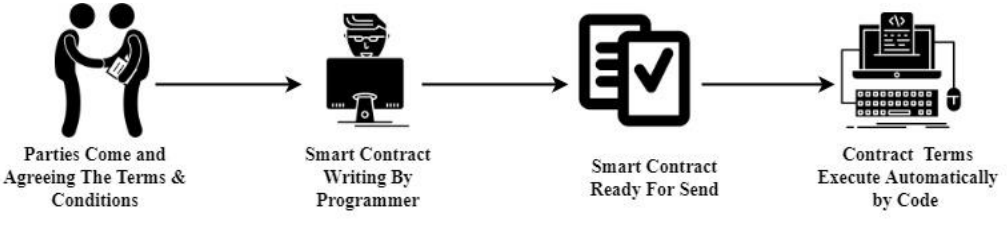
Figure 7. Smart Contract structure.